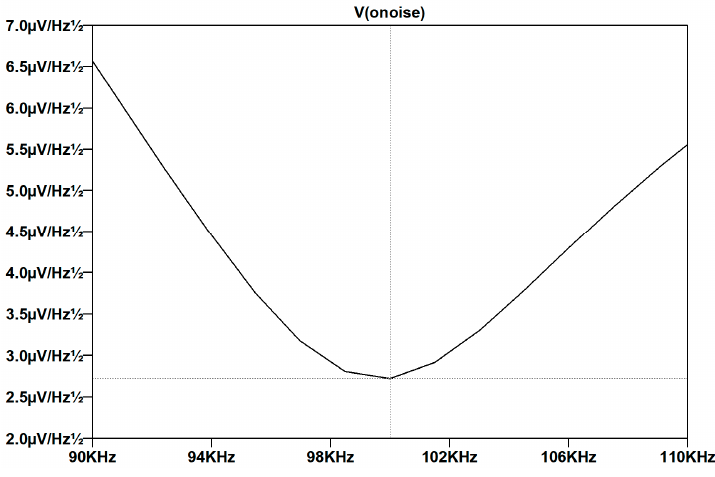
Figure 5. Voltage noise vs. frequency response curve.